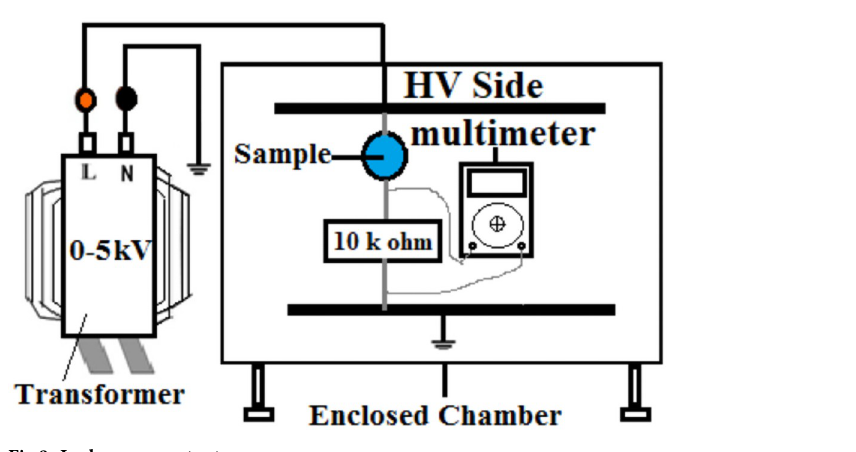
Fig 9. Leakage current